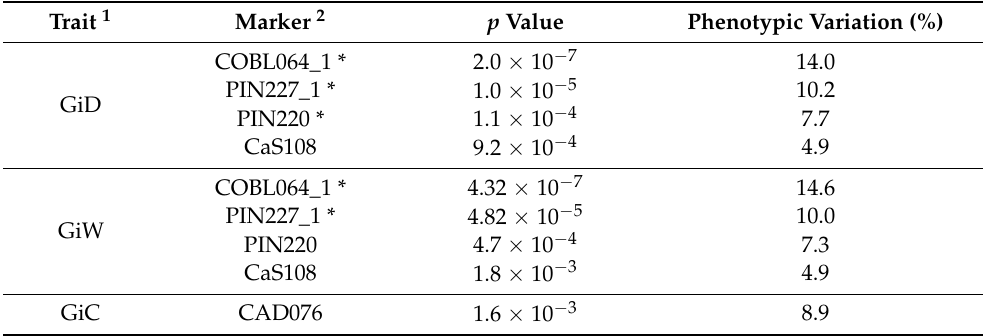
Table 1. Markers and trait association from the MLM + Q + K model.